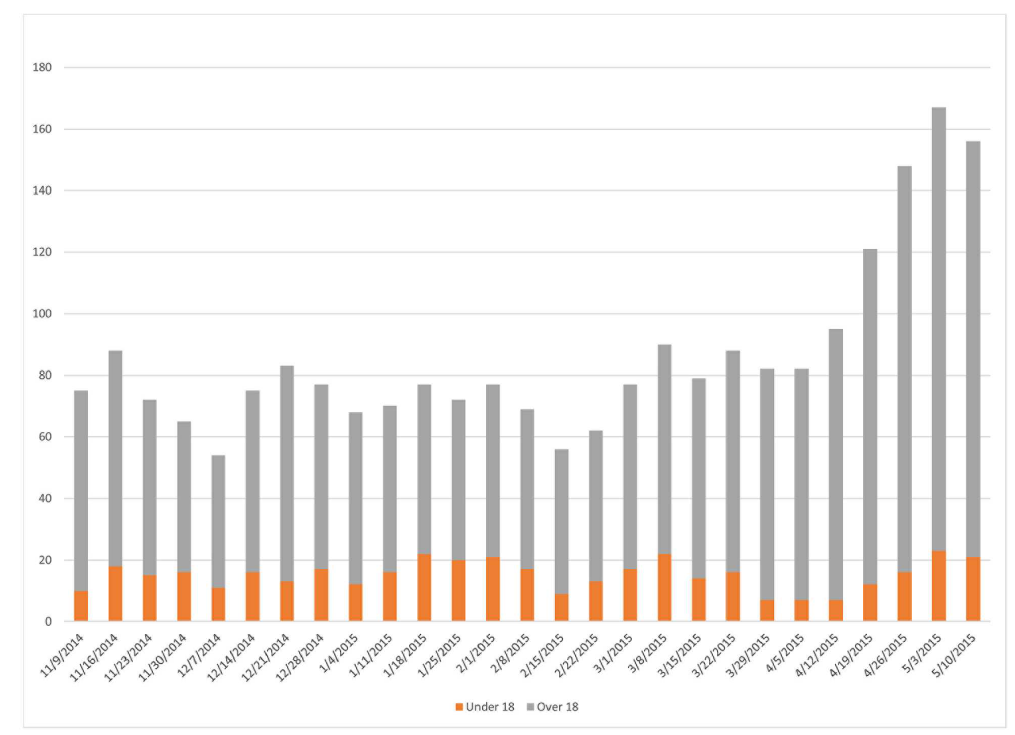
Fig 1. Weekly Numbers of Monitored Travelers by Age